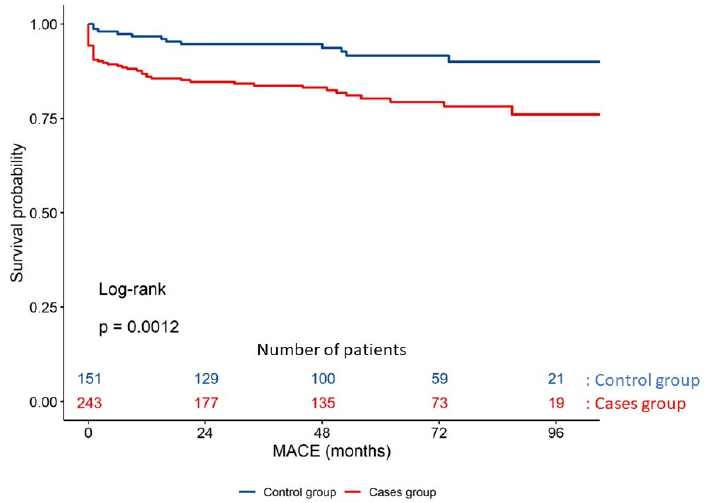
Figure 4. Clinical outcomes of case and control groups at the time of the first MACE .